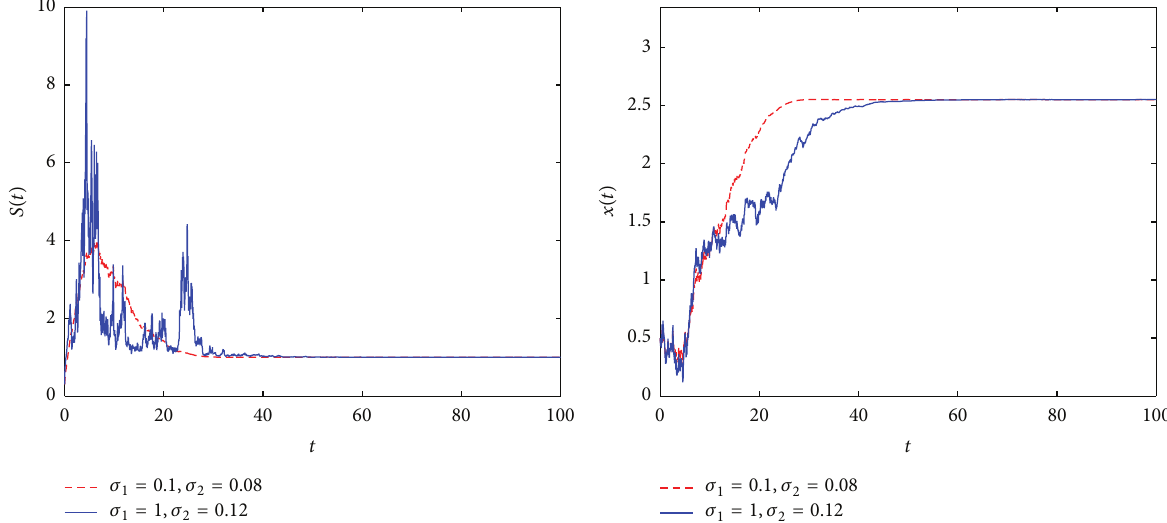
Figure 2: The dynamics of stochastic model with different values of 𝜎 1 and 𝜎 2 . Here 𝑆(0) = 0.3 , 𝑥(0) = 0.5 .